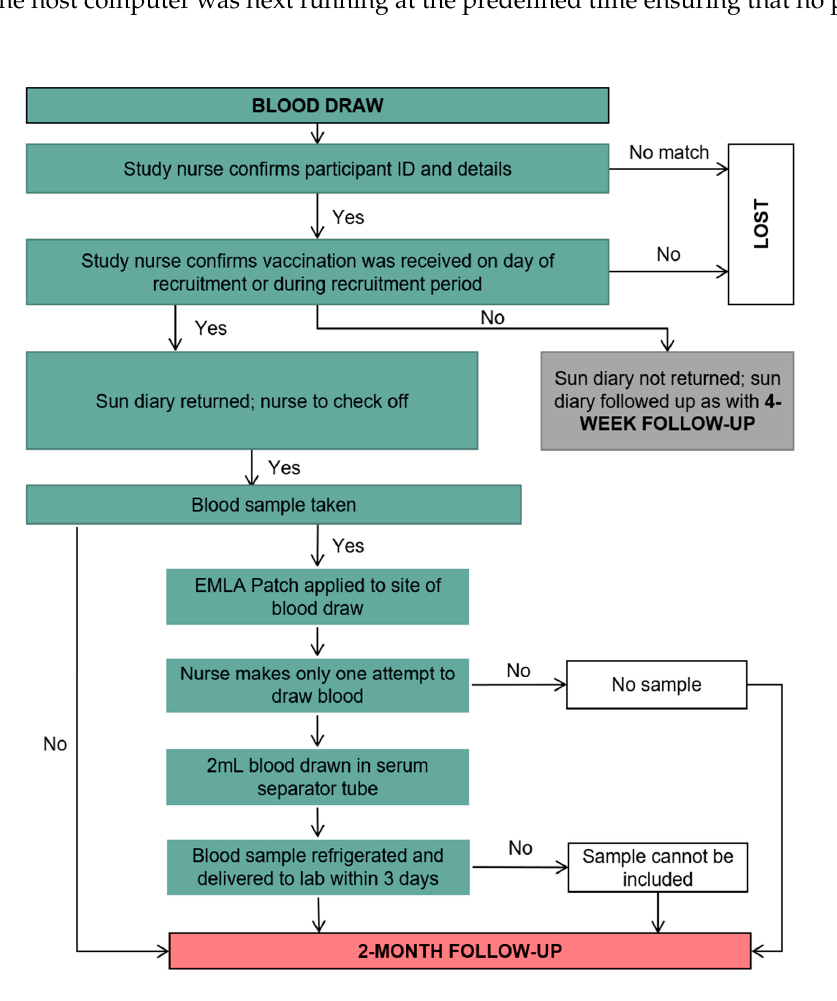
Figure 9. Two-month follow-up.